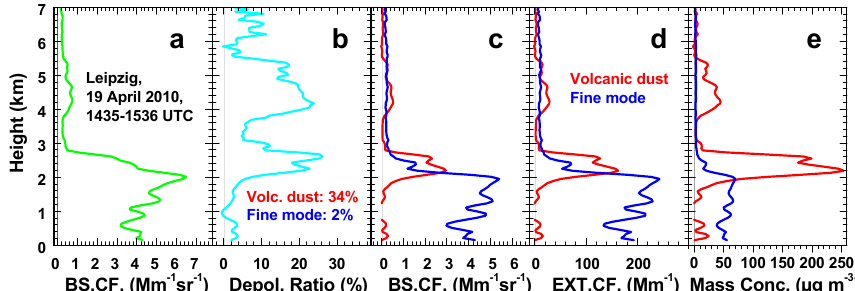
Fig. 4. Same as Fig. 2 except for Eyjafjallaj¨okull volcanic aerosol observed at Leipzig in April 2010 (Ansmann et al., 2011b).